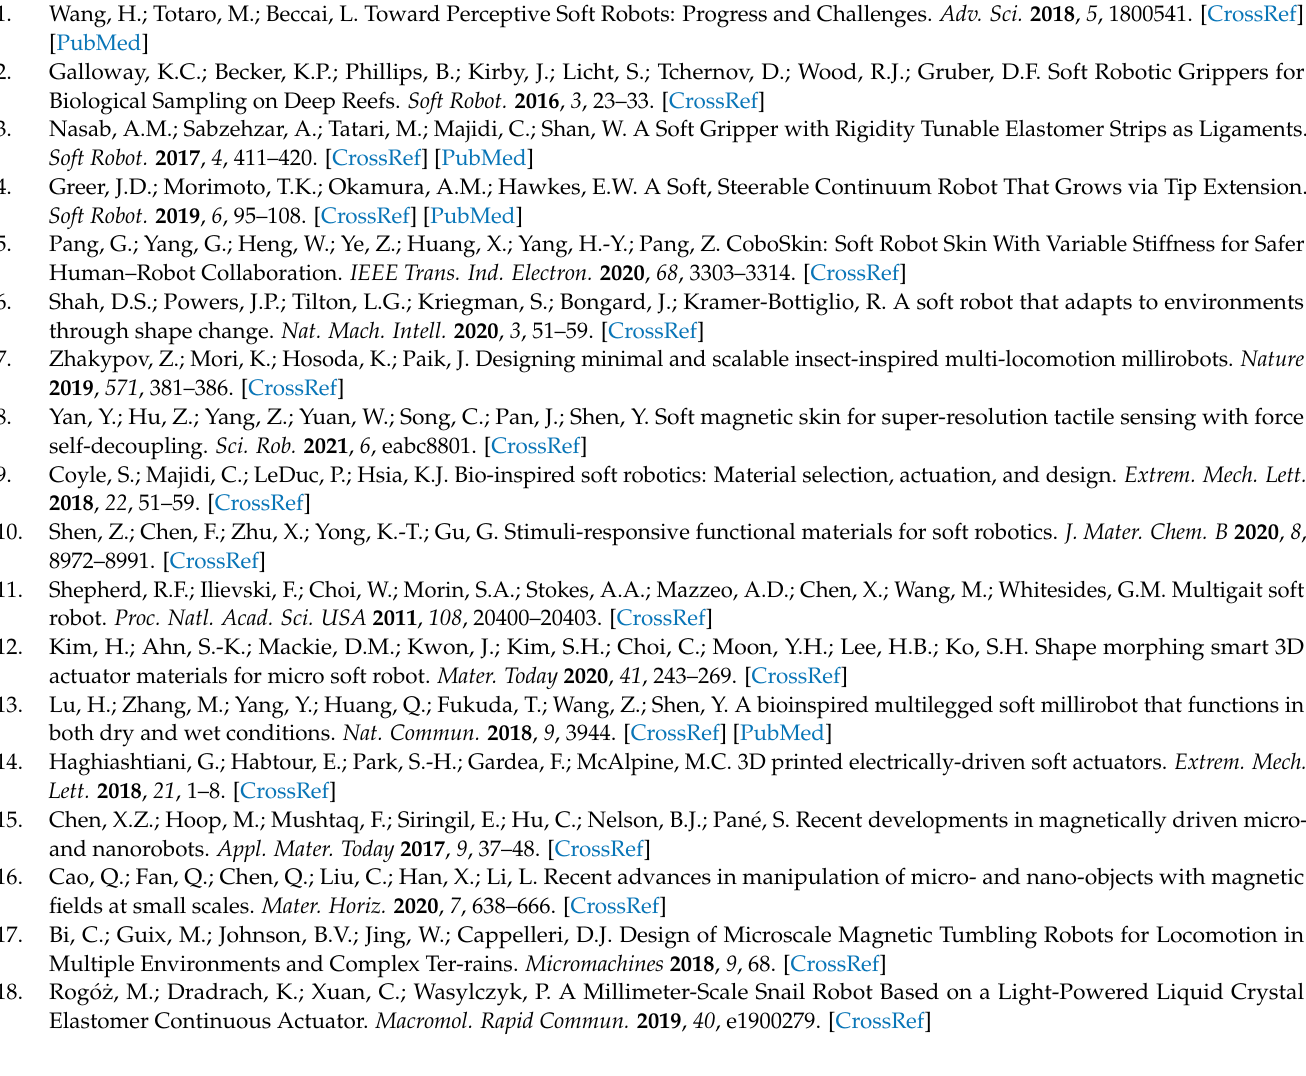
and after curing Figure S2: Internal magnetic chain distribution of the soft millirobot; Figure S3: SEM images of the robot’s cross-sectional view; Figure S4: Measured magnetic flux density (black dots) with respect to the distance from the surface of the permanent magnet along its axis. The curve is the numerical simulation based on the magnetic field model by MATLAB; Figure S5: Lifting angles of flexible robots under different magnetic fields. The lifting angle of the legged structure is greater than that of the legless structure at the same magnetic field; Figure S6: Analysis of friction during crawling; Figure S7: Analysis of friction during creeping; Figure S8: Cycling compression test of the soft robot (Load: 70 kg); Video S1: Multiple locomotion modes for soft